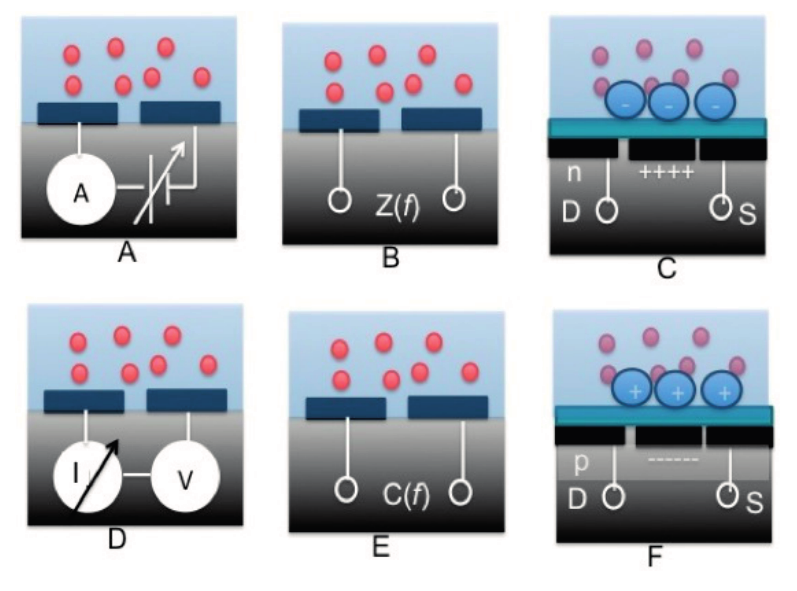
Figure 9. Interfacing techniques for electrochemical sensors: ( A ) voltometric; ( B ) impedometric; ( C ) p-channel ISFET; ( D ) amperometric; ( E ) capacitive; and ( F ) n-channel